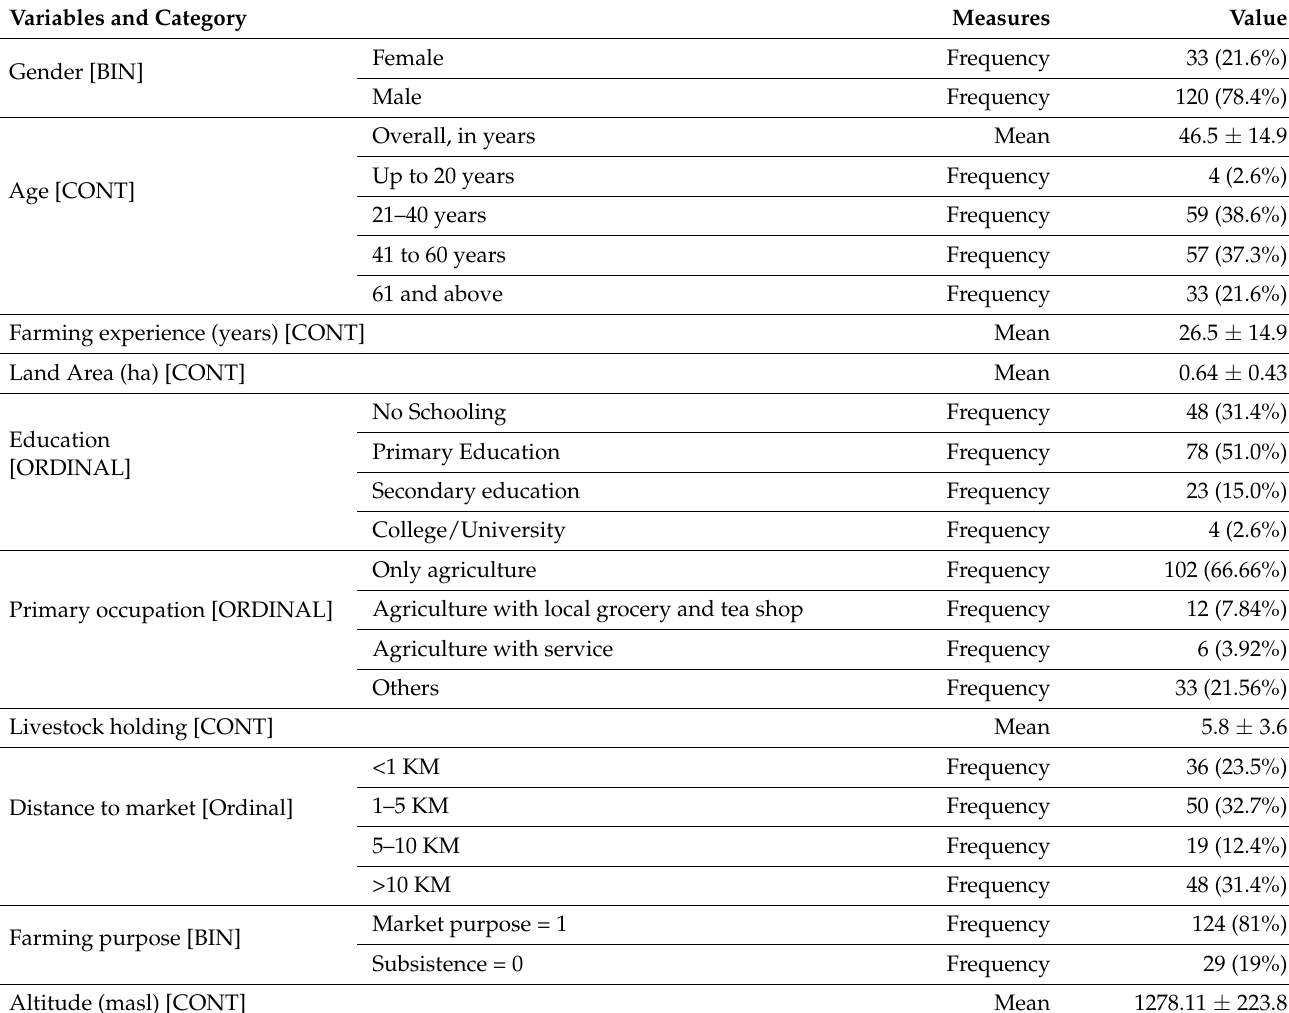
Table 2. Socio-demographic characteristics of